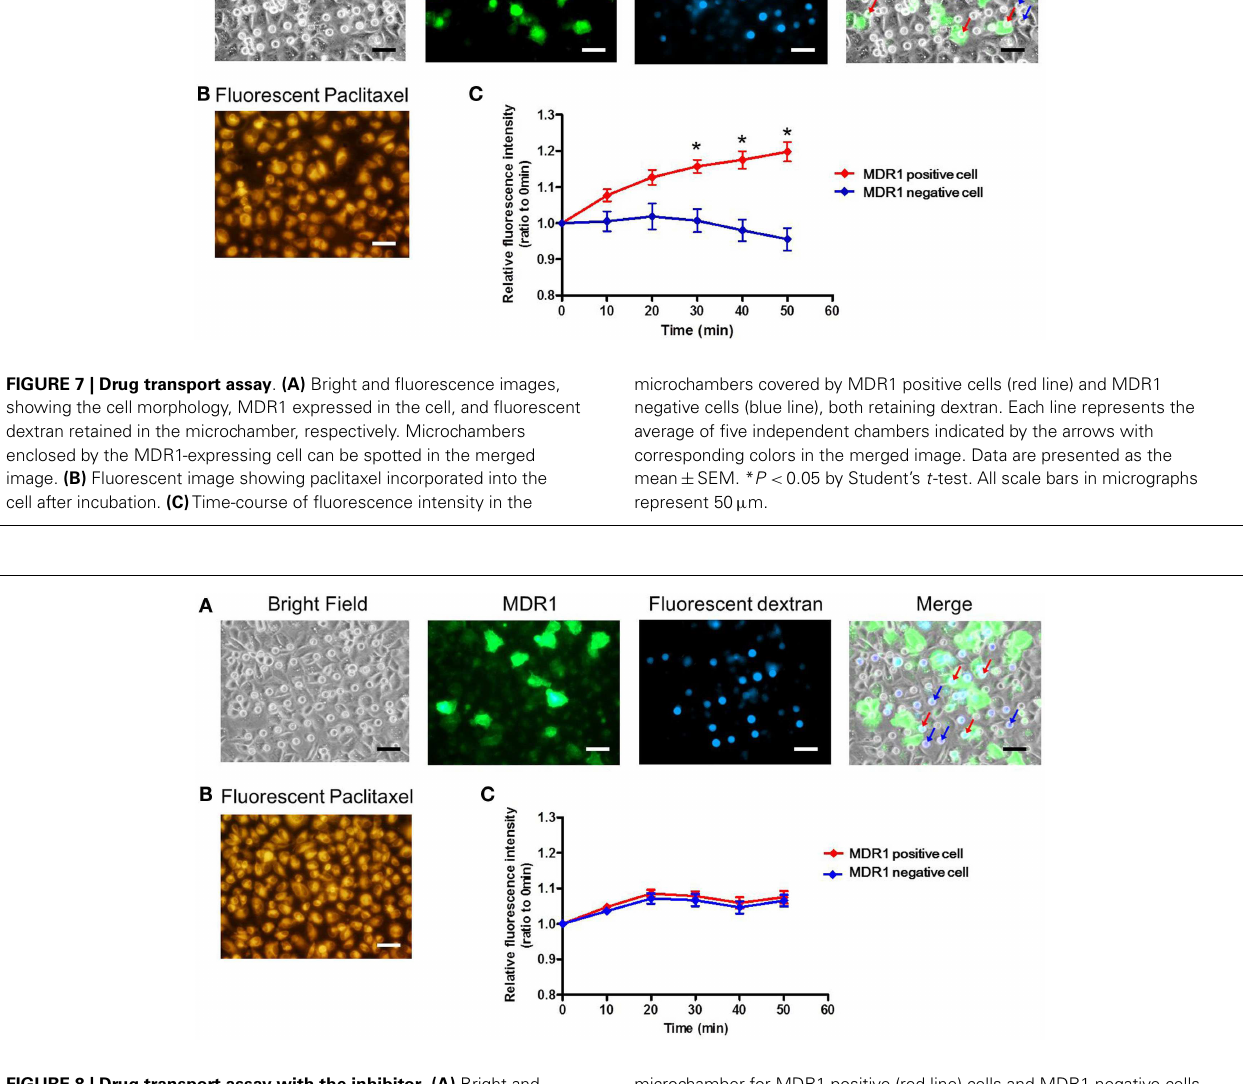
FIGURE 8 | Drug transport assay with the inhibitor . (A) Bright and fluorescence images, showing the cell morphology, MDR1 expressed in the cell, and fluorescent dextran retained in the microchamber, respectively. Microchambers enclosed by the MDR1-expressing cell can be spotted in the merged image. (B) Fluorescent image showing paclitaxel incorporated into the cell after incubation. (C) Time-course of fluorescence intensity in the